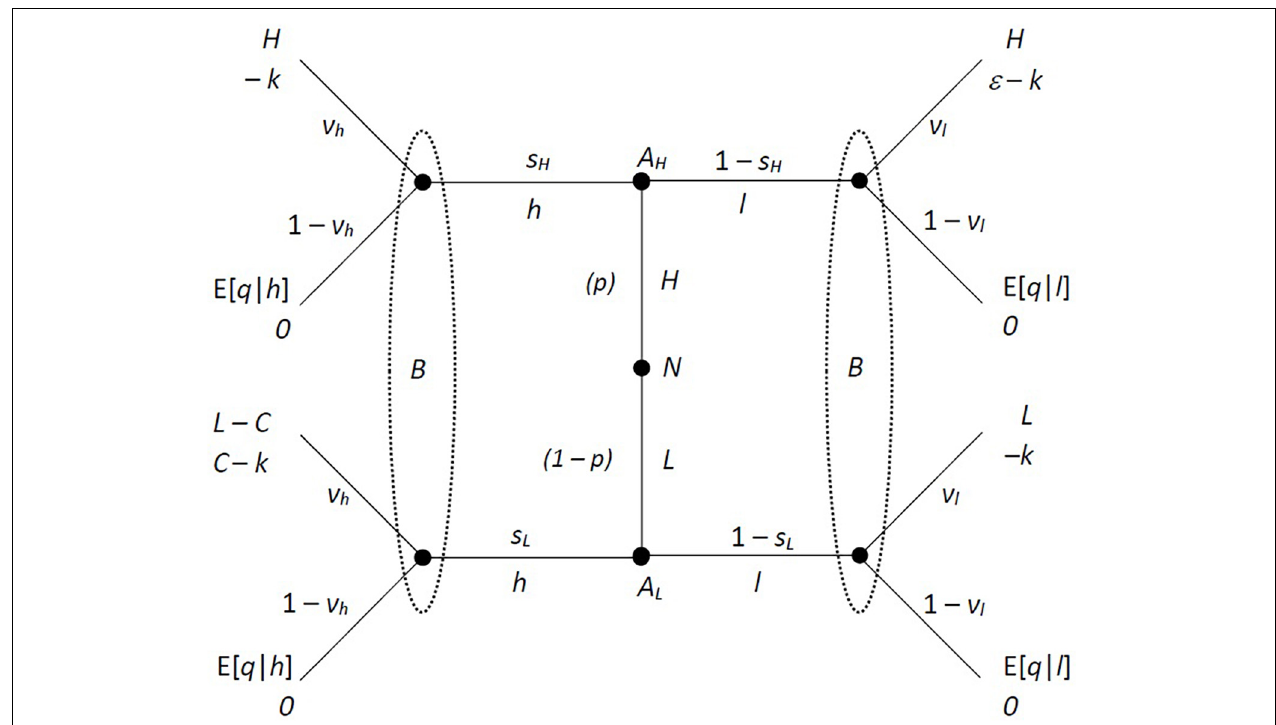
FIGURE 1 | Extensive form of the basic game